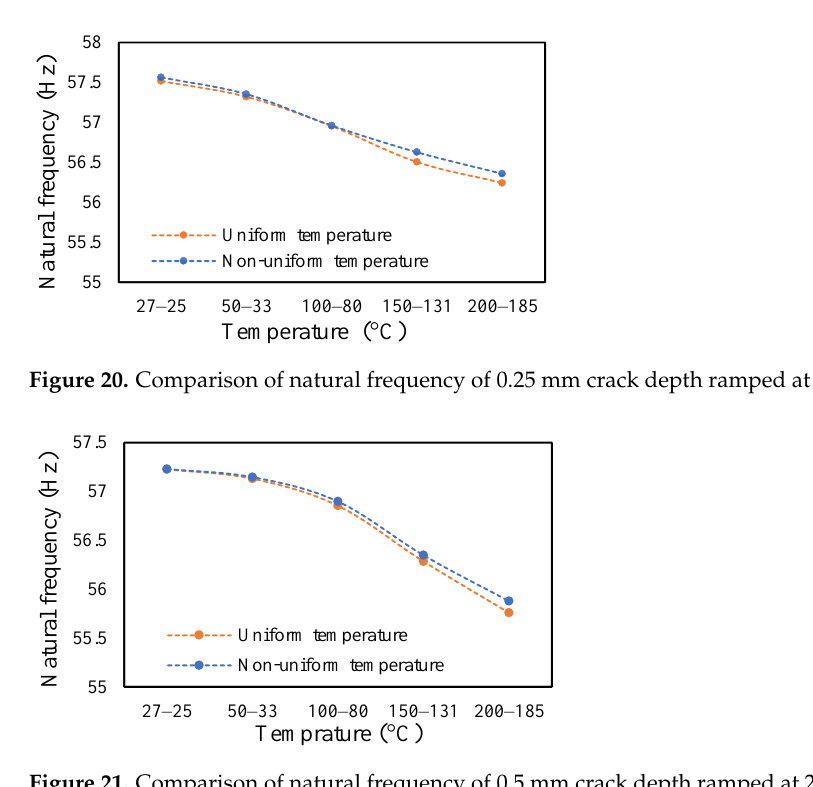
Figure 22. Comparison of natural frequency of 1 mm crack depth ramped at 2 °C/min. The variations in the amplitude are due to the differences in the frequencies at the respective temperature range. The modal amplitude of uncracked and cracked beams is presented in Figures 23 – 26. The modal parameters of the cantilever beam were examined with the changes in thermal properties due to the changes in temperatures. The